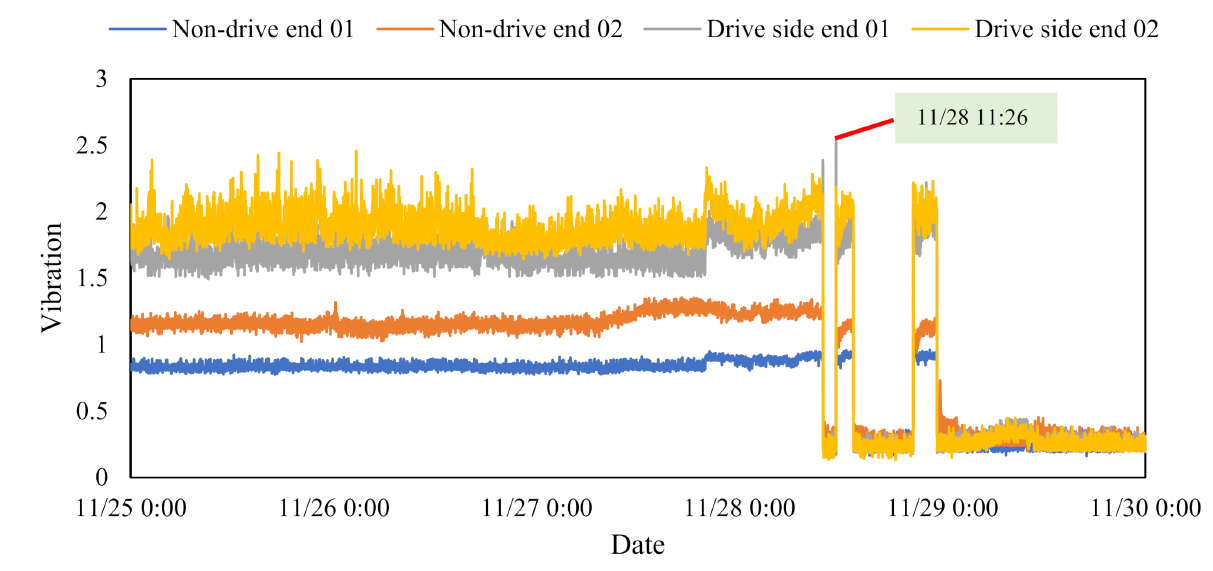
Figure 12. Operation data of a nuclear power